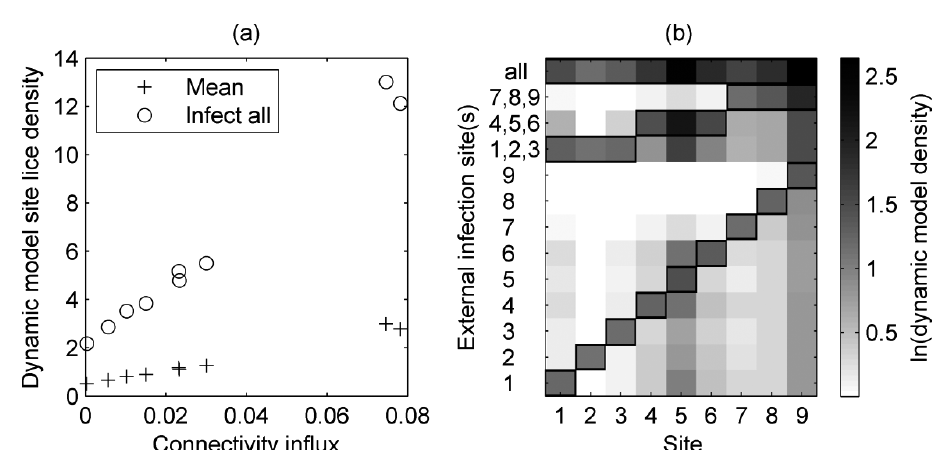
Fig. 4. Individual site densities. (a) Average site connectivity influx (over all 12 connectivity matrices) versus model mean site lice density for the pulse infection scenario, with external infection of 0.01 lice fish −1 d −1 and reproduction of 5 lice adult fe- male −1 d −1 . The mean of all individual site pulse infection scenarios (that is, external infection at different sites) is shown by ‘+’, while the case where all sites receive external infection is indicated by ‘ O ’. (b) Mean lice density at each site (over a whole model run) for runs where only particular sites receive external infection. Each row corresponds to an infection scenario, with the externally infected site outlined for clarity. In this case, connectivity influx is a weaker predictor of combined model density. Note the tendency for northward spread of lice between the